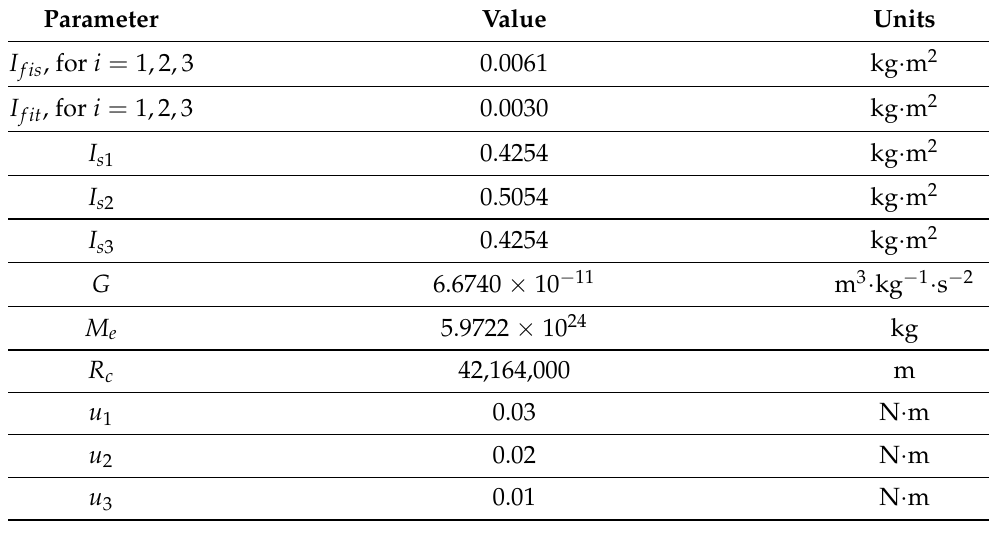
Table 1. Simulation parameters.